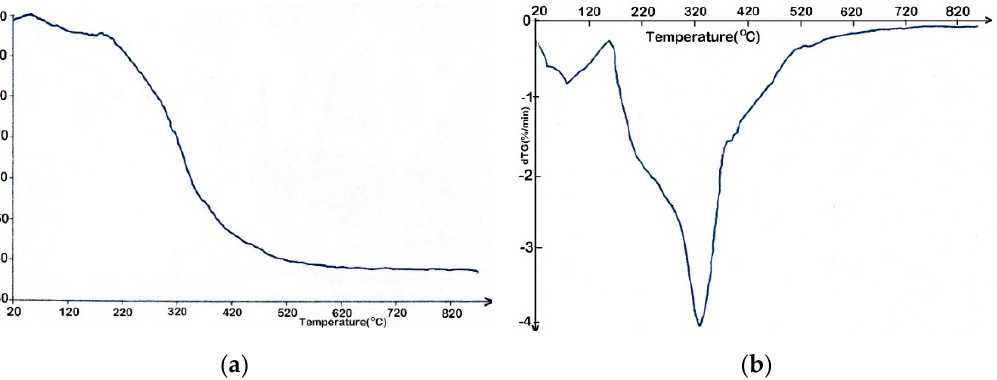
Figure 3. Thermal stability of RRB at 10 °C/min heating rate. TG curve of RRB ( a ) and DTG curve of RRB ( b ).